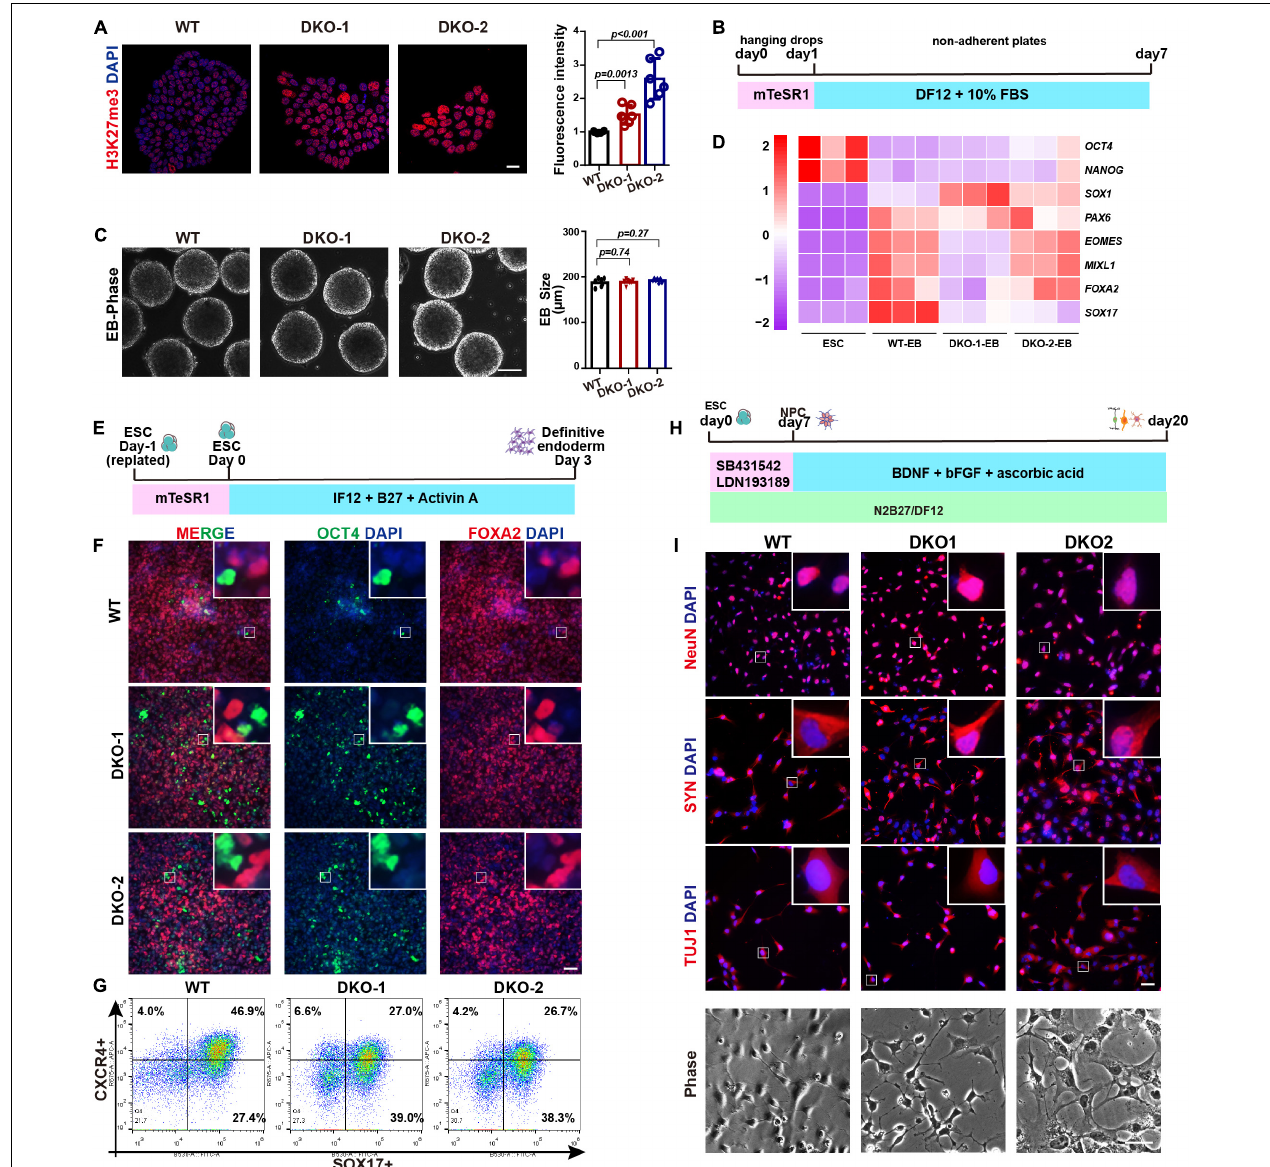
FIGURE 5 | The effect of double knockout of KDM6A and KDM6B on lineage differentiation. (A) The immunofluorescence staining and quantification of the H3K27me3 level in the KDM6-DKO and wild-type cells. Scale bar = 20 µ m. (B) Illustration of EB assay. (C) Morphology and size measurement of KDM6-DKO cells and wild-type EBs. Scale bar = 100 µ m. (D) RNA analysis of pluripotent and lineage markers of KDM6-DKO cells and wild-type EBs. (E) Illustration of definitive endoderm differentiation assay. (F,G) The immunofluorescence staining (F) and flow cytometric analysis (G) of endoderm markers in the KDM6-DKO and wild-type cells after 3 days of endoderm induction. Scale bar = 50 µ m. (H) Illustration of neuronal differentiation assay. (I) The immunofluorescence staining of neuronal markers and morphology in the KDM6-DKO and wild-type cells after 3 weeks of neuronal induction. Scale bar = 50 µ